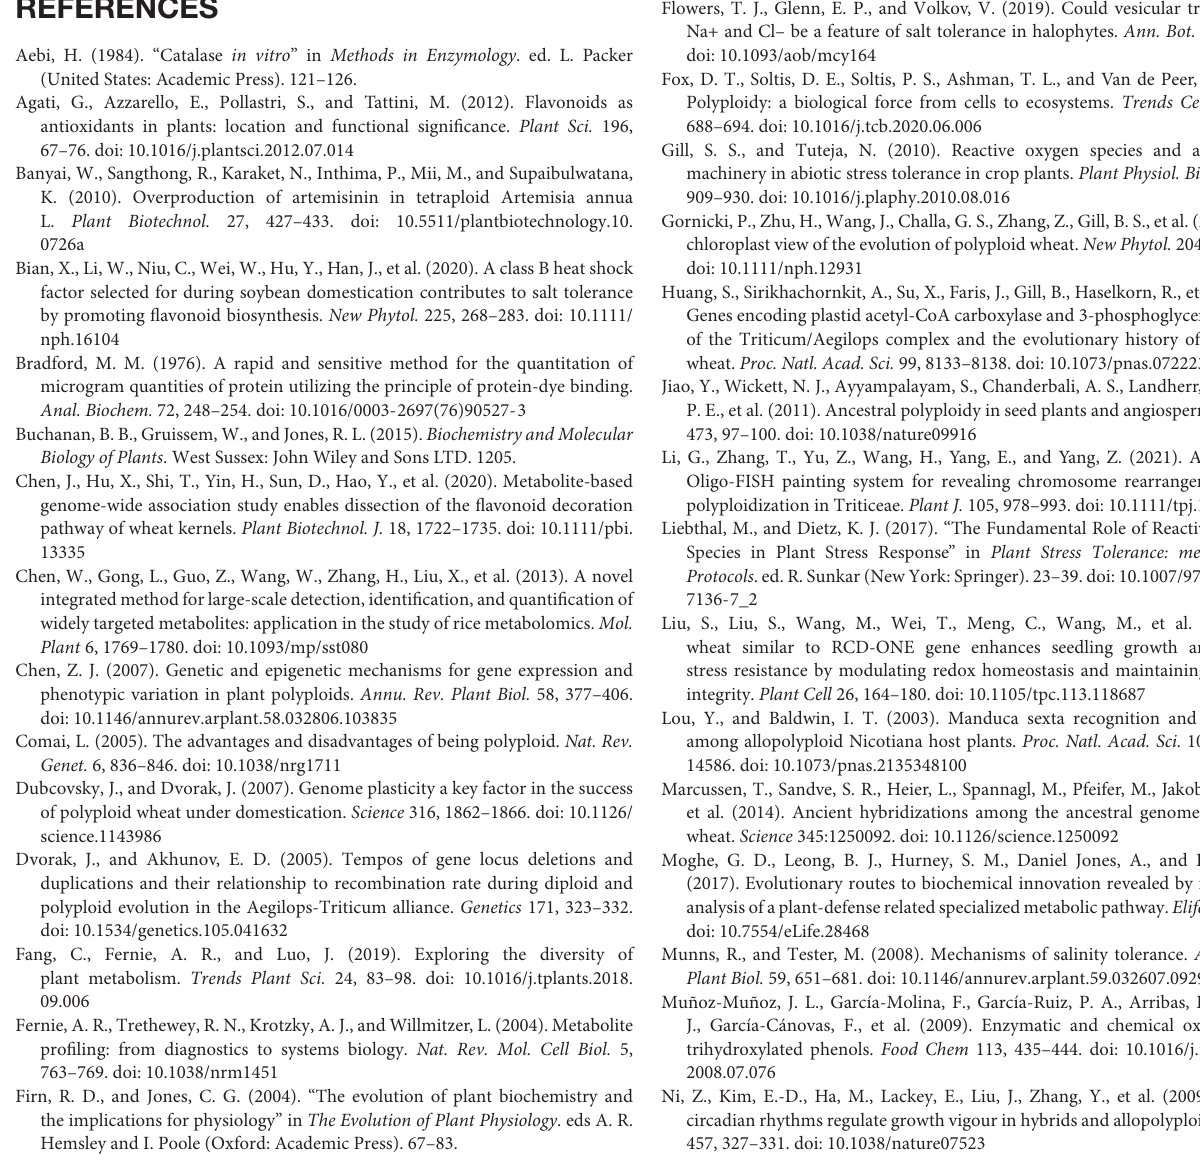
Supplementary Table 1 | Information of all detected metabolites. Supplementary Table 2 | Number of detected metabolites in each wheat line and each organ. CL, control leaf; SL, stress leaf; CR, control root; SR, stress root. Supplementary Table 3 | Relative concentration of the metabolites that were not detected in all AA plant samples. CL, control leaf; SL, stress leaf; CR, control root; SR, stress root. Supplementary Table 4 | Information of all transgressively accumulated metabolites in leaves of a synthetic tetraploid wheat line under control condition. Transgressive up accumulation: concentration of metabolite in 4x was higher than that of either of its parents (4x/AA > 2 VIP > 1 and 4x/S l S l > 2 VIP > 1); transgressive down accumulation: concentration of metabolite in 4x was lower than that of either of its parents (4x/AA < 0.5 VIP > 1 and 4x/S l S l < 0.5 VIP > 1). Supplementary Table 5 | Information of all transgressively accumulated metabolites in leaves of a synthetic tetraploid wheat line under salinity stress.